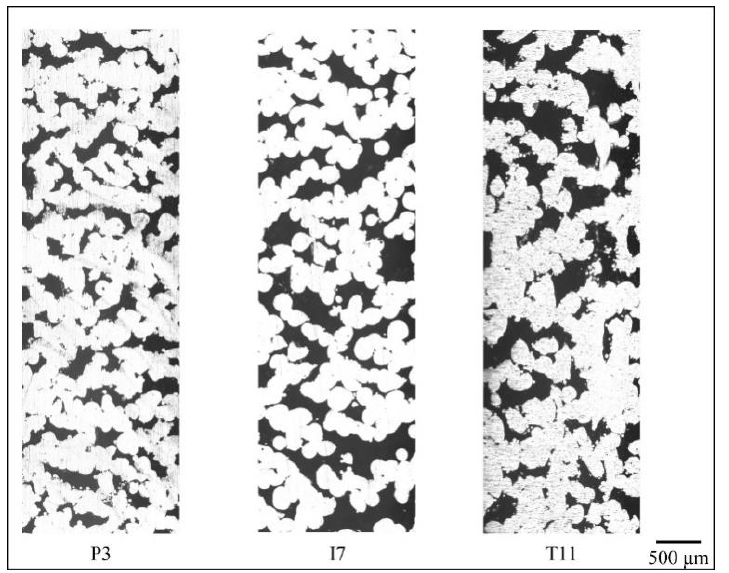
Figure 8. Flow paths in P3, I7, and T11 (lateral direction corresponds to z or printing direction in SLM.).